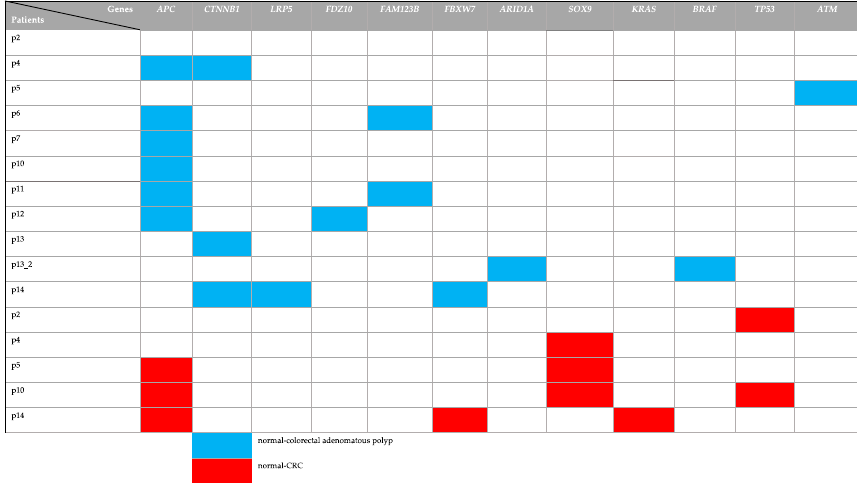
Figure 2. Comparison of the alter gene between The Cancer Genome Atlas (TCGA) and Thai patients. The rows show the list of patients. The columns show the list of gene names.